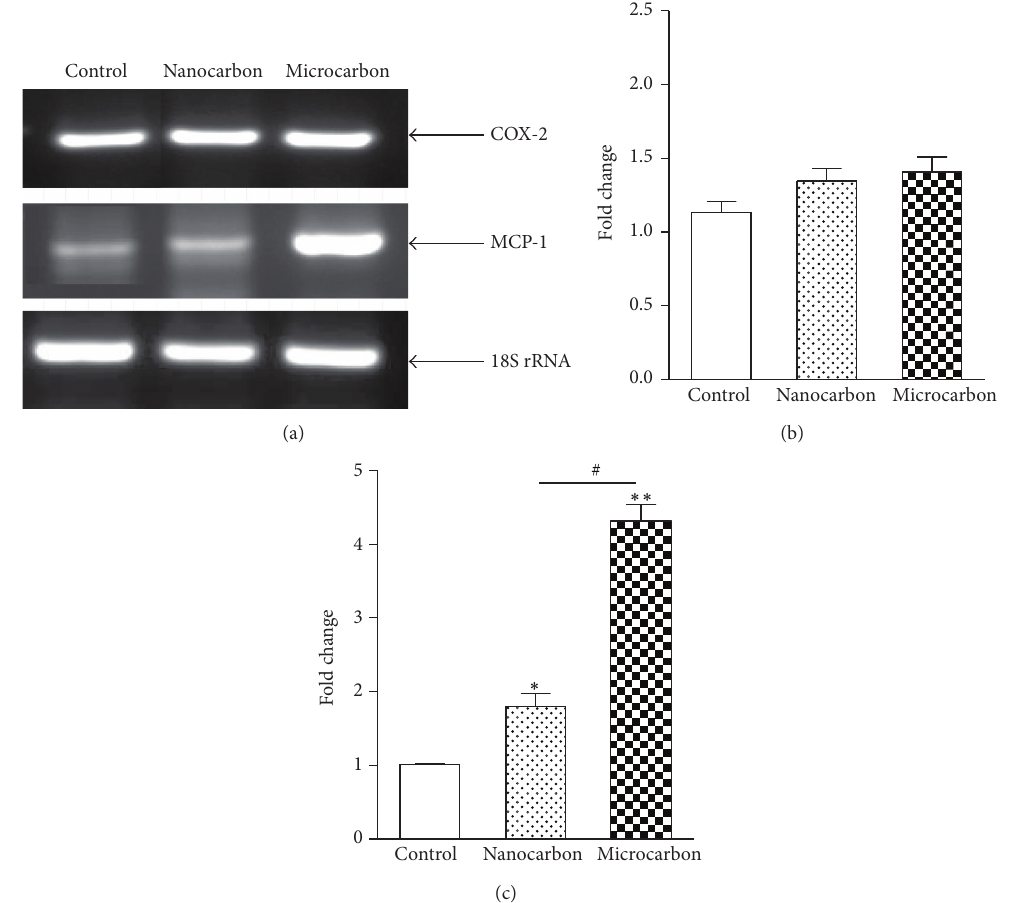
Figure 7: Effects of carbon particles (nano and micro) on mRNA levels of COX-2 and MCP-1 gene. THP-1 cells were exposed to carbon particles at their TC-50 concentration (nano carbon: 591.4 𝜇 g/mL and micro carbon 687.1 𝜇 g/mL). (a) COX-2 and MCP-1 gene expression on agarose gel. Gene expressions are analyzed by densitometric analysis using Image J software. Results are also expressed as a fold change over the control group. (b) Densitometric bar diagram of COX-2 gene. (c) Densitometric bar diagram of MCP-1 gene. Statistically significant differences were assessed as compared to the controls ( ∗ 𝑃 < 0.05 and ∗∗ 𝑃 < 0.01 ). # 𝑃 < 0.001 indicates significant difference between the particle size.